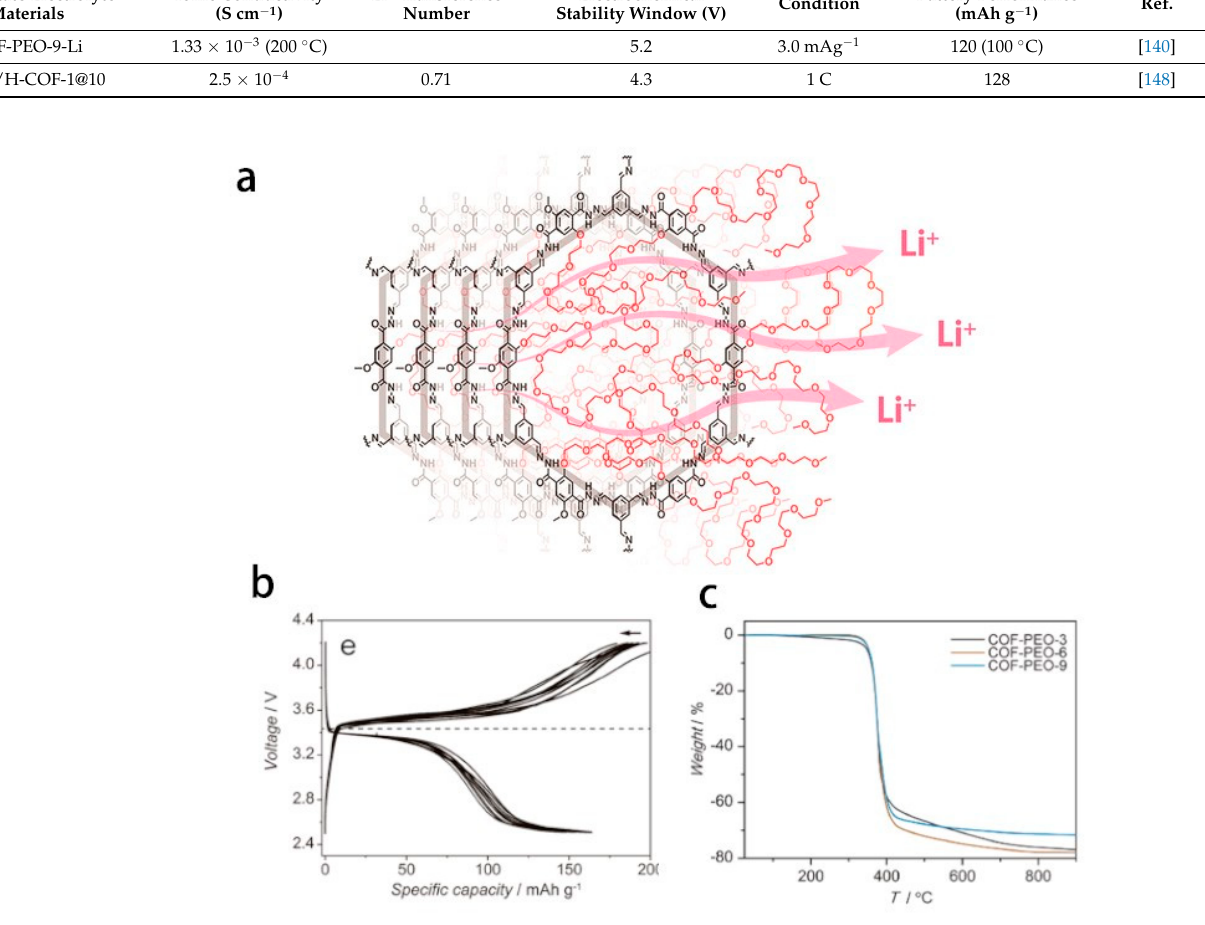
Table 3. Summary of the major performances of COF-based SSEs.